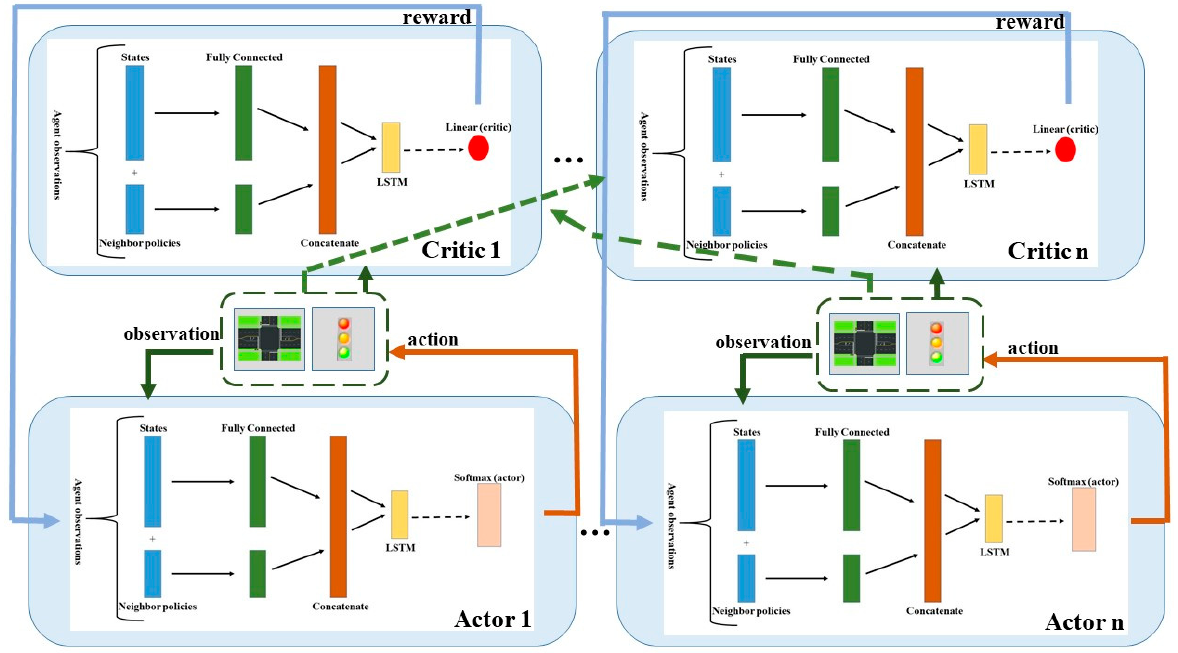
Figure 5. The DNN architecture and training.